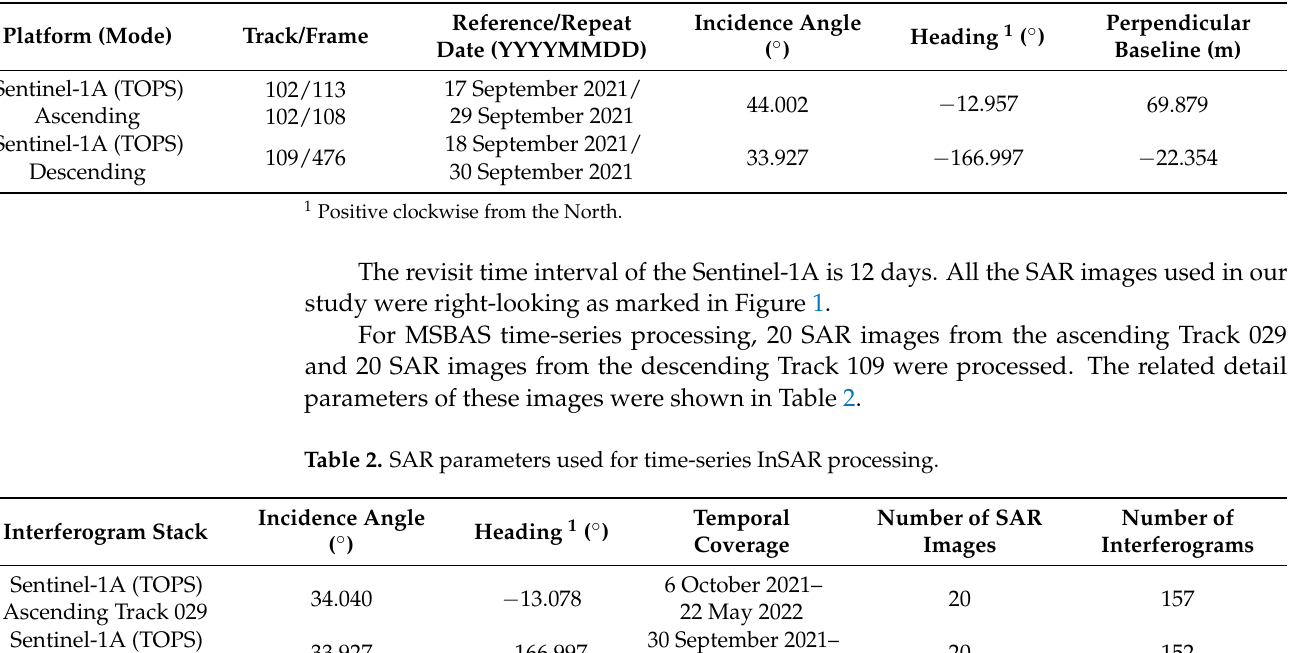
Table 1. SAR parameters used for D-InSAR processing.